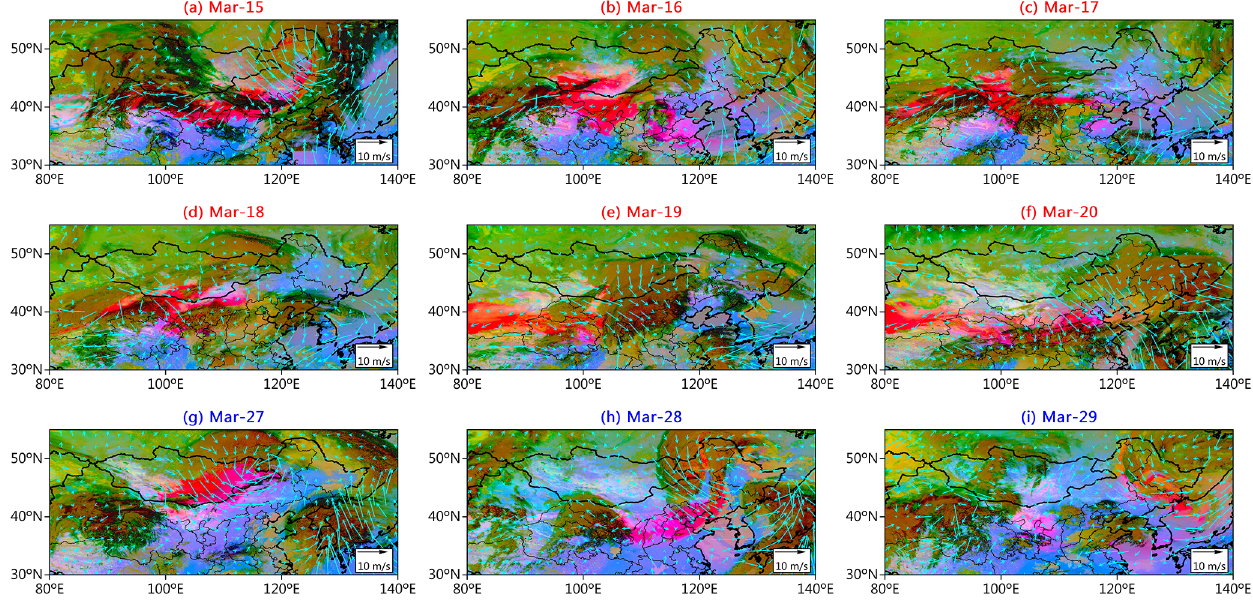
Figure 2. Evolution of dust plumes (magenta) as revealed by Himawari-8 dust RGB composite images at 13:00CST during (a–f) the 3.15 SDS event (15–20 March 2021) and (g–i) the 3.27 SDS event (27–29 March 2021), respectively. Overlaid on the RGB imagery is the ERA5 daily mean wind vectors at 10m.